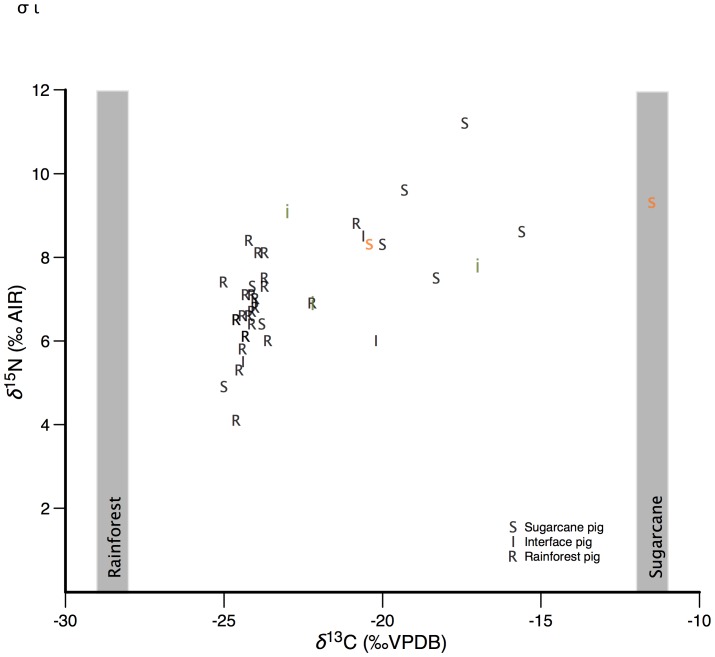
δ13C and δ15N values of feral pig base hair.The stable isotope composition of base hair were taken from 41 feral pigs captured at Rainforest (R), Savanna (S), or Interface environments (I). Sugarcane and Rainforest δ
13C and δ
15N value endmembers are plotted for comparison. A lowercase letter (s, i) indicates that the site contains ready access to native C4 vegetation.